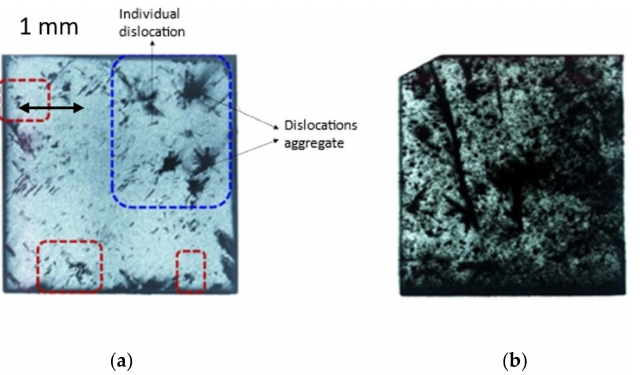
Figure 8. The XRT photographs of the two CVD diamond plates taken from Shikata (ref. [42]). The plate in ( a ) shows aggregates of dislocations within the blue and red areas. Some single dislocations are also visible. In contrast, ( b ) has a much higher density of the dislocation aggregates and bundles. The image is taken in the (404) crystallographic plane and the dimensions of the plates are about 3.5 mm × 3.5 mm. The image is taken from ref. [42]: Shikata, S. Diamond dislocations analysis by X-ray topography. Funct. Diam. 2022 , 2 , 174. Reprinted by permission of Taylor & Francis Ltd, http://www.tandfonline.com (accessed on 1 February 2023) on behalf of Zhengzhou Research Institute for Abrasives & Grinding Co.,